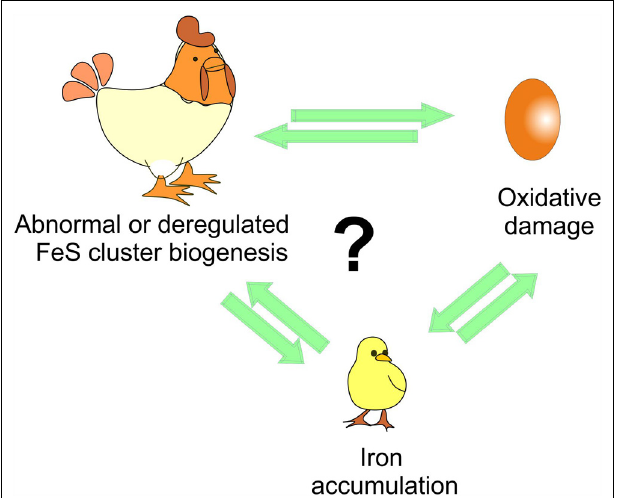
effect of iron–sulfur (FeS) cluster deregulation and/or of the oxidative stress and of course which of the two comes first as in the chicken and egg causality